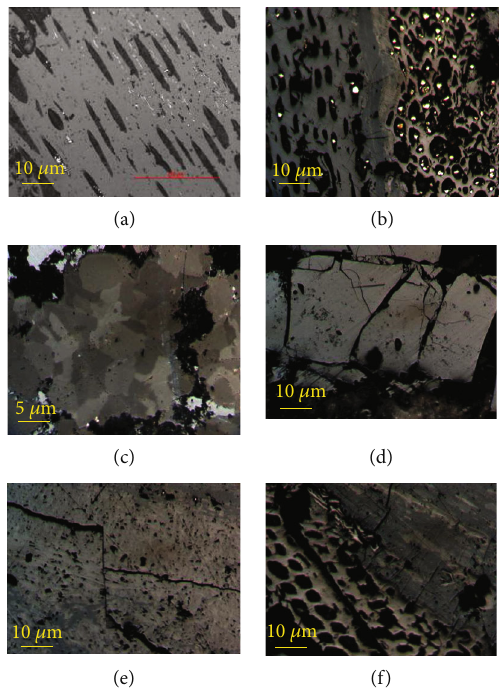
Figure 6: Microphotographs of macerals. (a) Cavity pores in fusinite; (b) cavity pores in telinite and fusinite; (c) intergranular pores among minerals particles; (d) cleats in telocollinite; (e) fractures in fusinite; (f) cavity pores and fractures in telinite and